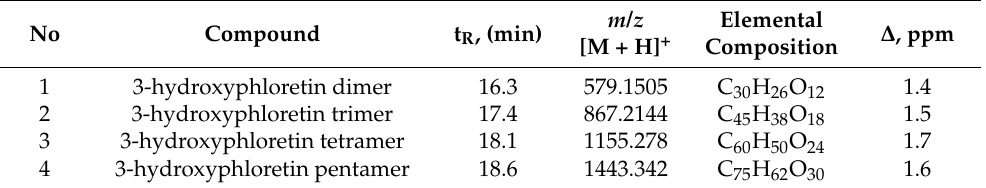
Table 1. Major compounds and their tentative identification by HPLC-ESI(+)-HRMS.